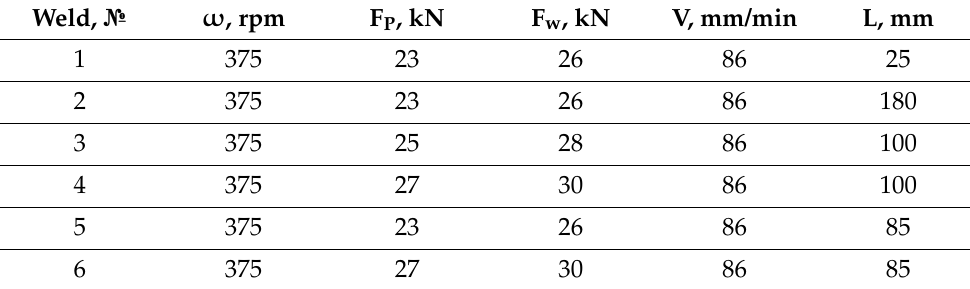
Table 4. Friction stir welding